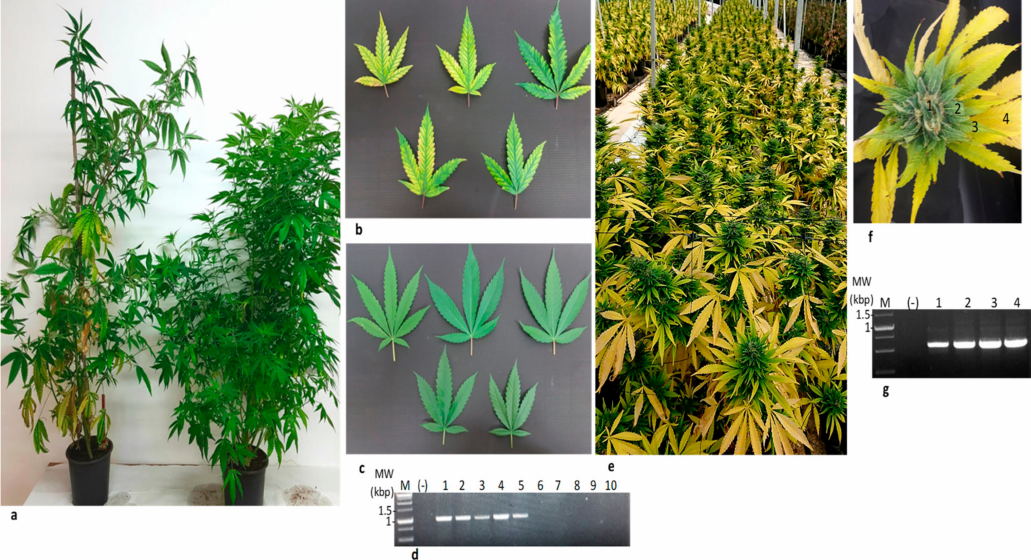
Figure 5. Cannabis lettuce chlorosis virus (LCV) isolate transmitted via shoots.( a ) Stunted growth of cannabis plant propagated from LCV infected shoots (left) compared to the growth of cannabis plant propagated from un-infected shoots (right). ( b ) Chlorotic leaves of the LCV infected cannabis plant shown in (a). ( c ) Un-infected cannabis leaves. ( d ) RT-PCR detection of LCV-Can infected (lanes 1–5) and un-infected (lanes 6–10) cannabis leaves using the primers RNA2-F-6090 and RNA2-F-7094 (Table 3). ( e ) Symptoms of propagated LCV-can infected plants in an authorized farm (AF). This severe stage was observed one-month post-fertilizer arrest, traditionally done before flower pickup. ( f ) A symptomatic flower of LCV infected propagated cannabis plant dissected to four samples (1–4). ( g ) RT-PCR of LCV infected cannabis-dissected flower (lanes 1–4) using the primers RNA2-F-7628 and RNA2-F-8189 for RNA2 (Table 3). MW-Molecular weight, M-Marker, (-) Negative